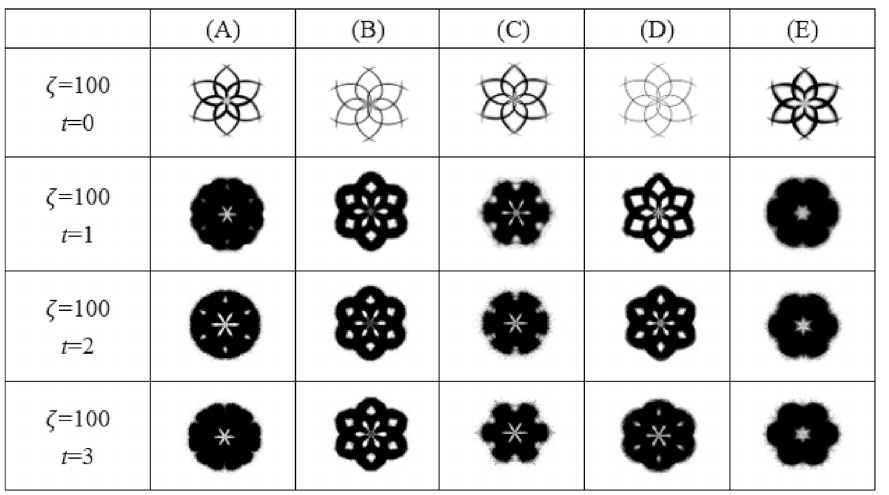
Figure 11. SDP figures in weighting coefficient 100 and time delay coefficient 0 to 3 for five different cars.